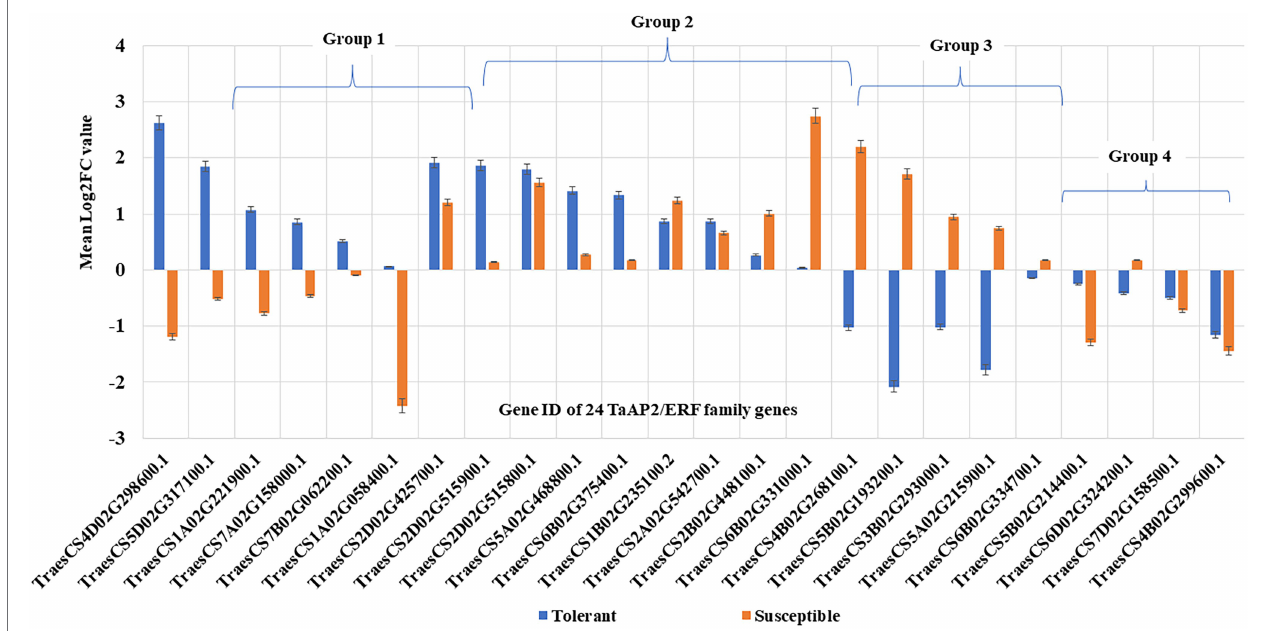
FIGURE 7 | Gene regulation pattern of 24 TaAP2/ERF TF genes in tolerant and susceptible wheat genotypes based on RT-qPCR results. The 24 TF genes are classified into four groups according to the nature of their expression in different genotypes: Group 1 . Genes up-regulated in tolerant but down-regulated in susceptible (six genes: TraesCS4D02G298600.1 , TraesCS5D02G317100.1 , TraesCS1A02G221900.1 , TraesCS7A02G158000.1 , TraesCS7B02G062200.1 , and TraesCS1A02G058400.1 ); Group 2 . Genes up-regulated in both tolerant and susceptible (nine genes: TraesCS2D02G425700.1 , TraesCS2D02G515900.1 , TraesCS2D02G515800.1 , TraesCS5A02G468800.1 , TraesCS6B02G375400.1 , TraesCS1B02G235100.2 , TraesCS2A02G542700.1 , TraesCS2B02G448100.1 , and TraesCS6B02G331000.1 ); Group 3 . Genes up-regulated in susceptible but down-regulated in tolerant (five genes: TraesCS4B02G268100.1 , TraesCS5B02G193200.1 , TraesCS3B02G293000.1 , TraesCS5A02G215900.1 , and TraesCS6B02G334700.1 ); and Group 4 . Genes down-regulated in both tolerant and susceptible (four genes: TraesCS5B02G214400.1 , TraesCS6D02G324200.1 , TraesCS7D02G158500.1 , and TraesCS4B02G299600.1